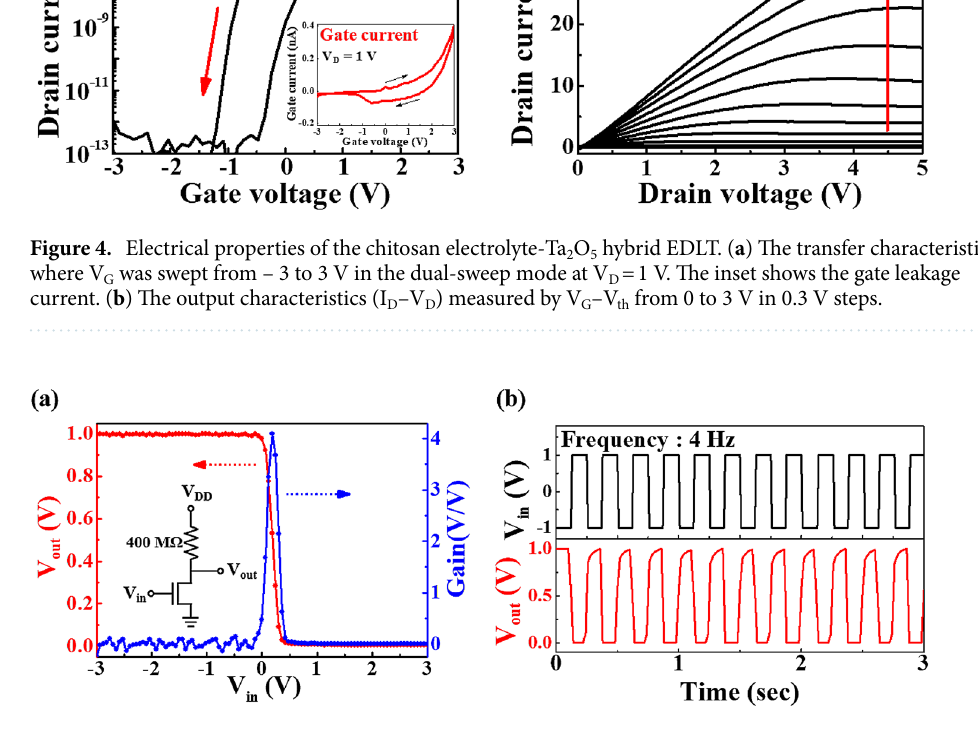
Figure 5. Resistor-loaded inverter characteristics of the chitosan-Ta 2 O 5 hybrid EDLT. ( a ) The VTC curve and voltage gain were obtained by connecting a load resistor of 400 MΩ in series (V DD = 1 V). The inset is a simple schematic of an equivalent circuit for a resistor-loaded inverter. ( b ) The dynamic inverting response properties at a frequency of 4